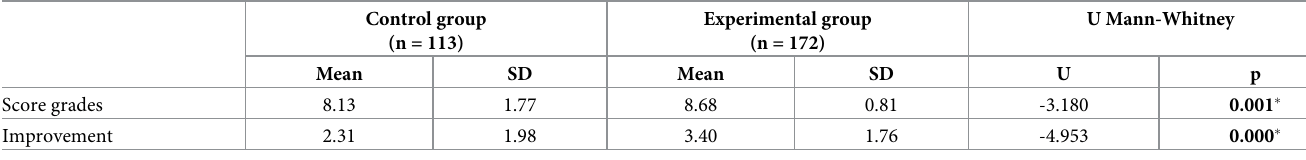
Table 3. Score grades and improvement: Experimental vs. control